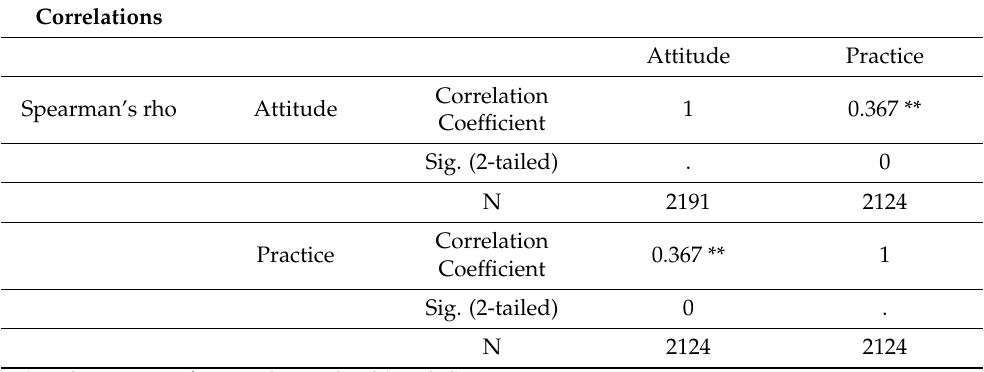
Table 7. Association of the Spearman correlation between attitude and practice. Correlations Spearman’s rho Attitude